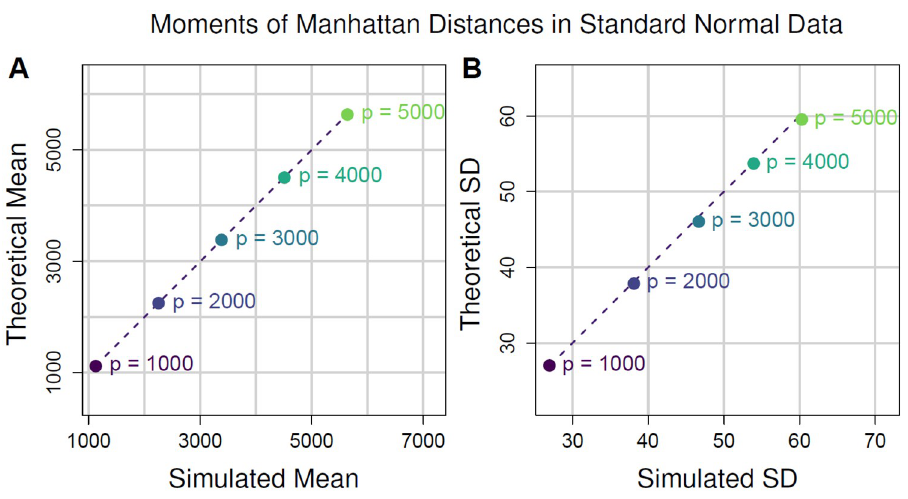
Fig 11. Comparison of theoretical and sample moments of Manhattan (Eq 1) distances in standard normal data. (A) Scatter plot of theoretical vs simulated mean Manhattan distance (Eq 41). Each point represents a different number of attributes p . For each value of p we fixed m = 100 and generated 20 distance matrices from standard normal data and computed the average simulated pairwise distance from the 20 iterations. The corresponding theoretical mean was then computed for each value of p for comparison. The dashed line represents the identity (or y = x ) line for reference. ( B ) Scatter plot of theoretical vs simulated standard deviation of Manhattan (Eq 1) distance (Eq 42). These standard deviations come from the same random distance matrices for which mean distance was computed for A . Both theoretical mean and standard deviation approximate the simulated moments quite well.